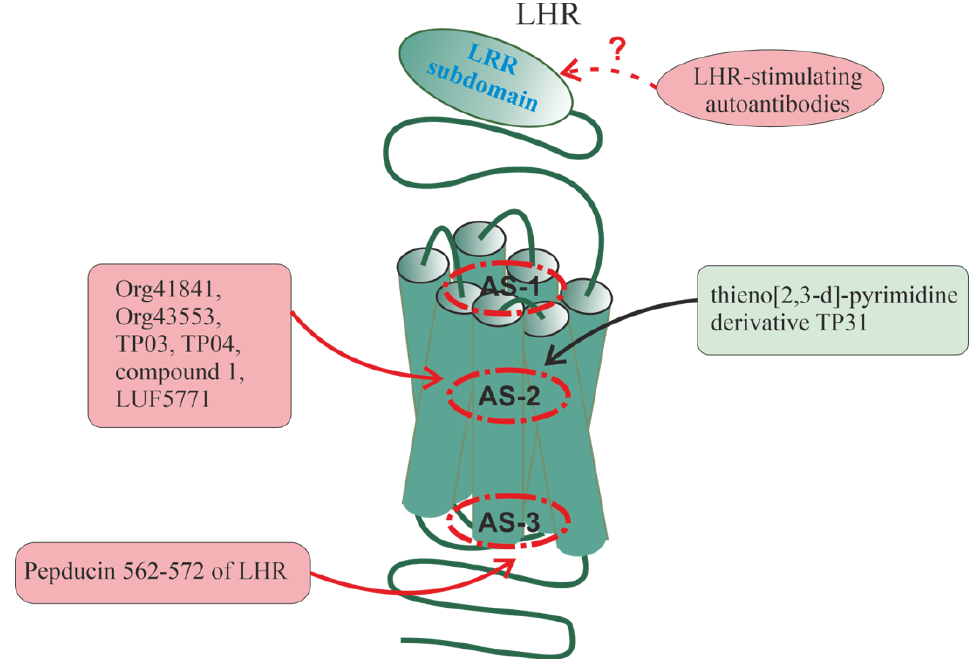
Figure 5. Allosteric regulators of the luteinizing hormone receptor. Like TSHR, LHR has a large extra- cellular domain in which an orthosteric site is located, and the small LHR regulators bind to allosteric sites located in the cavity of the AS-2 locus. The following low-molecular-weight compounds specifi- cally interact with allosteric sites in the AS-2 locus: thieno[2,3-d]-pyrimidine derivatives Org41841, Org43553, TP03, TP04 and their analogs (allosteric LHR-agonists or ago-PAMs, predominantly acti- vate G s -proteins), the derivatives of 1,3,5-pyrazole (compound 1) and terphenyl (LUF5771) (allosteric LHR-agonists), and thieno[2,3-d]-pyrimidine derivative TP31 (allosteric LHR-antagonists). Pepducin NKDTKIAKK-Nle-A(562–572)-K(Palm)A (ICL3 of LHR) interacts with the intracellular allosteric site and functions as an allosteric LHR agonist. Autoantibodies to the extracellular regions of LHR have been suggested but have not been characterized to date. Allosteric regulators that increase receptor activity (full agonists and ago-PAMs) are placed in red squares, while allosteric regulators with neutral antagonist activity are placed in green